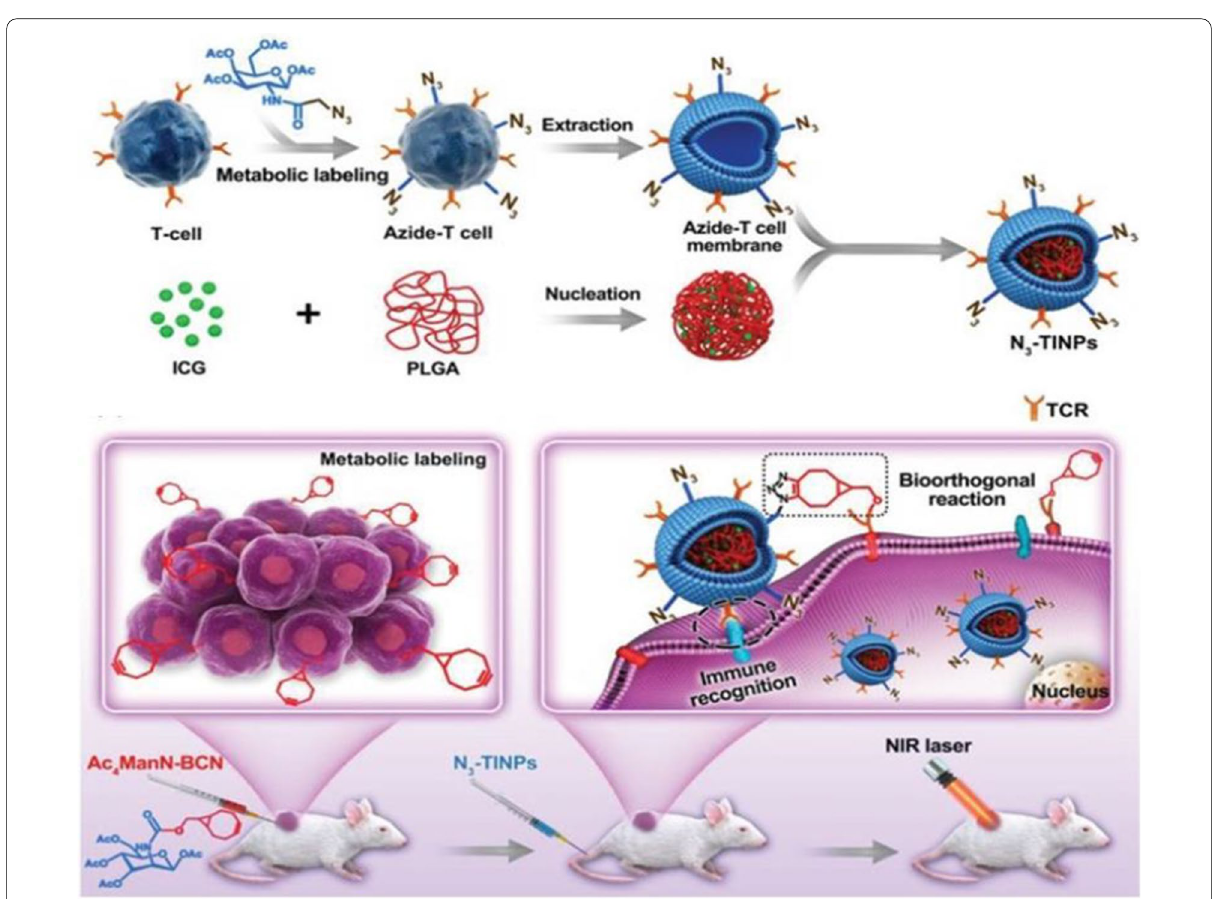
Fig. 4 Schematic illustration of N 3 -labeled T cell membrane-biomimetic nanoparticles with a dual-targeting mechanism for highly efficient photothermal therapy [51]. Copyright 2019 WILEY–VCH Verlag GmbH & Co. KGaA,